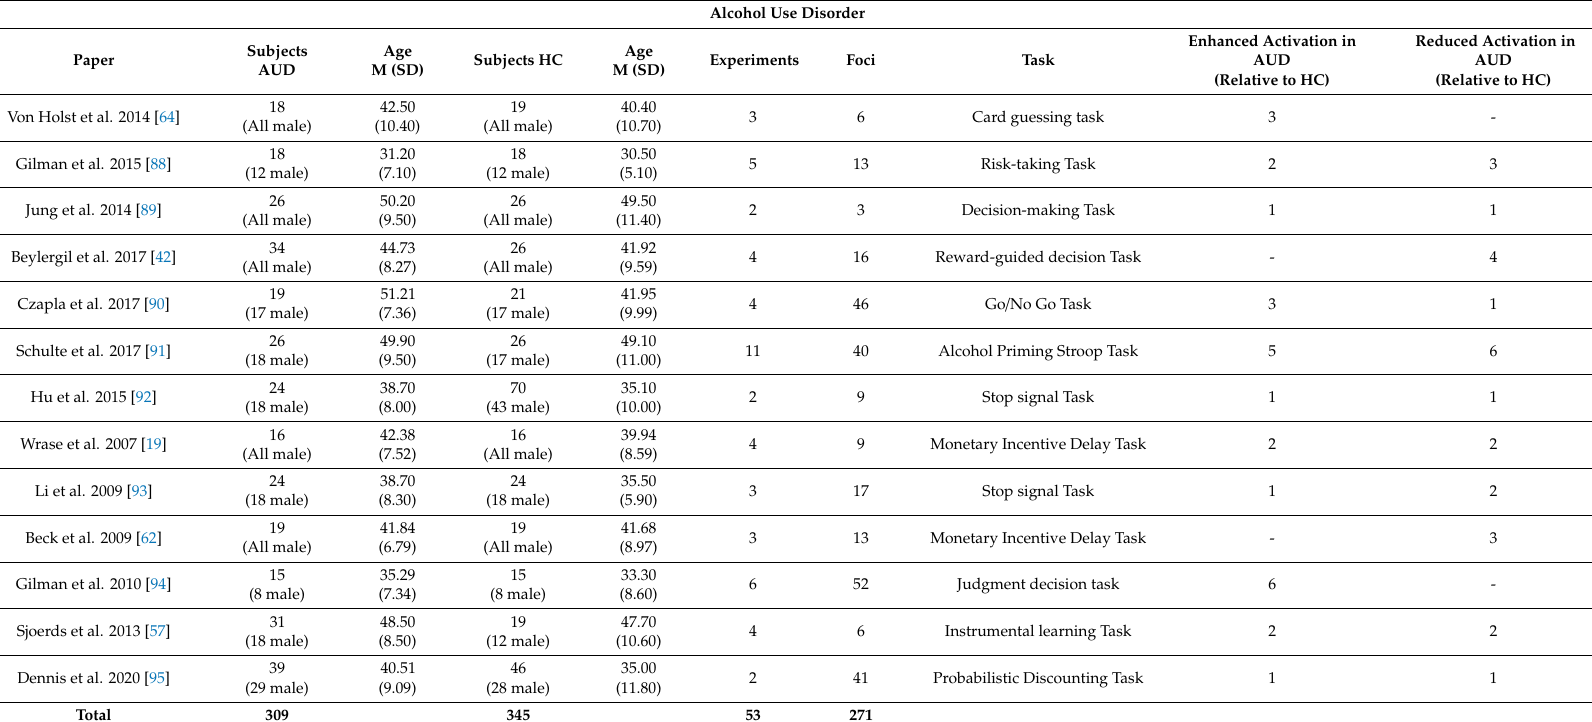
Table 2. Complete list of papers included in the meta-analysis for Alcohol Use Disorder. For each paper, details about the number of participants, the experimental paradigms, and the included contrasts in the studies are provided. AUD = Alcohol Use Disorder; HC = healthy